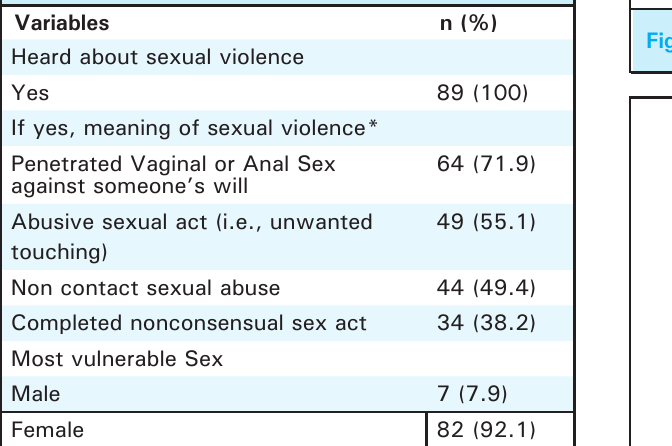
Table 1. Knowledge regarding meaning of sexual violence.